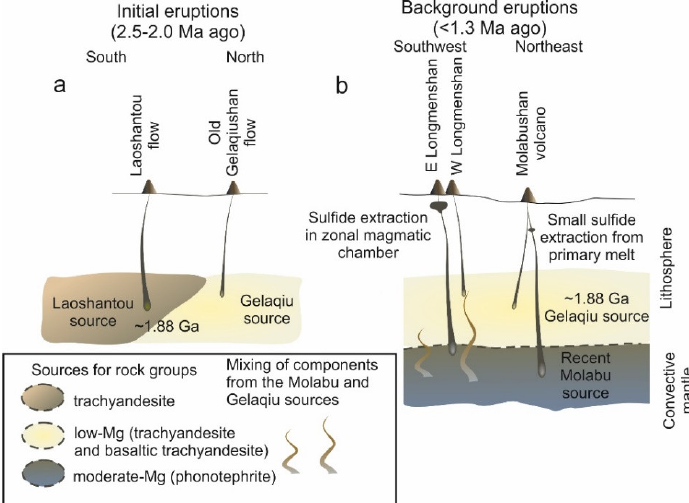
Figure 18. Initial eruptions of liquids from the individual lithospheric Laoshantou and Gelaqiu sources generated beneath Wudalianchi at ca. 1.88 Ga ago ( a ) and subsequent eruptions of mixed liquids from the mantle lithospheric Gelaqiu and sub-lithospheric Molabu sources accompanied by extraction of sulfides from liquids of the latter ( b ). The position of the Molabu source below the Gelaqiu one is shown conventionally. This source might be a chamber within the lithospheric mantle. We infer that the Laoshantou and Gelaqiu lithospheric mantle sources are associated with the common reservoir that is defined in the Cenozoic volcanic rocks of East Asia. From the Ce/Pb, Th/Yb, and Ta/Yb ratios of low- and moderate-Mg rock groups, we suggest that the old lithospheric